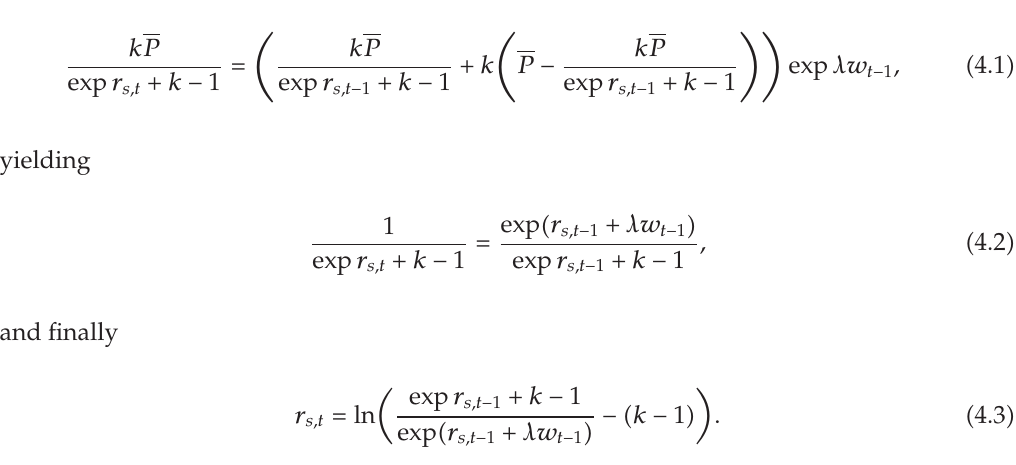
(cid:7) 0 . 15 , and α 1